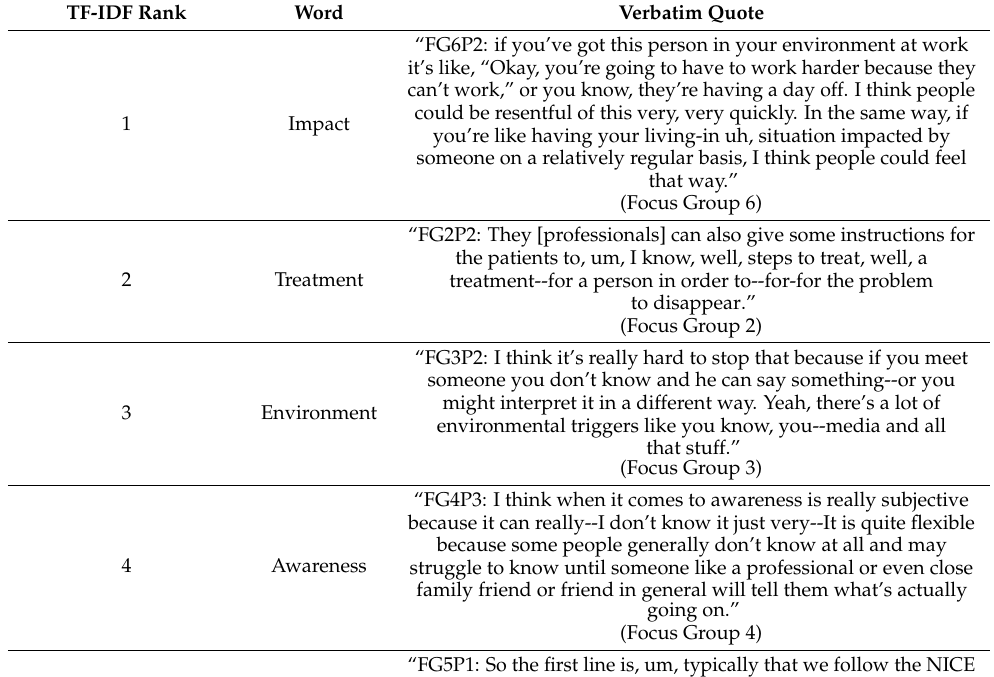
Table 4. Focus group TF-IDF rank score quote